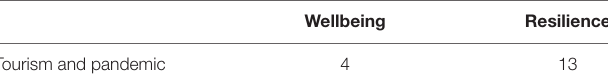
TABLE 2 | Number of articles distributed according to the positive variables: Wellbeing and